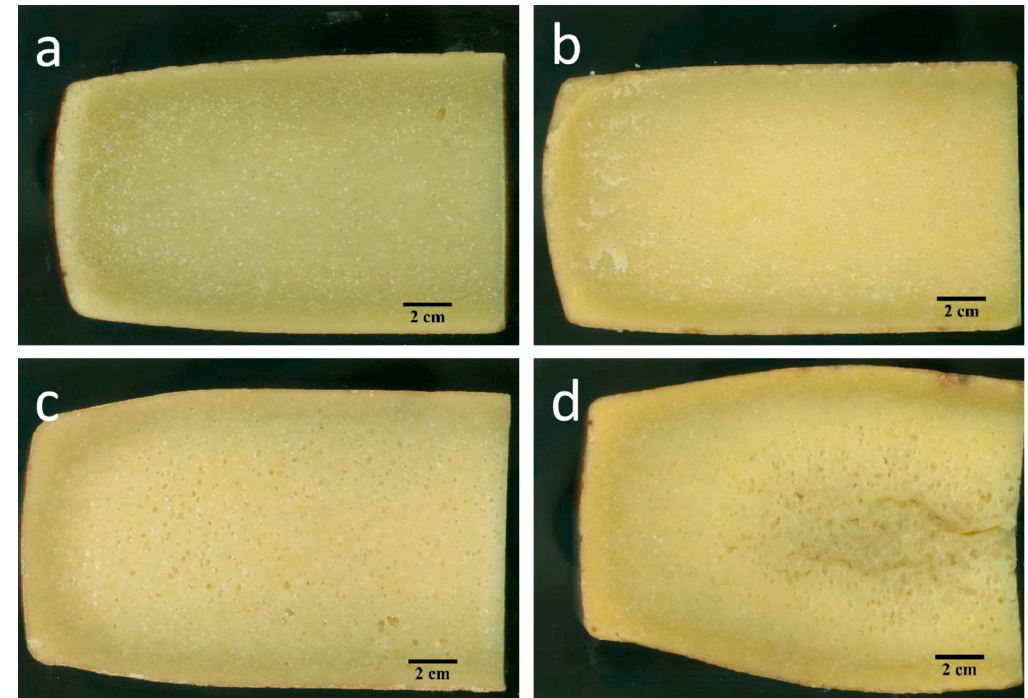
Figure 6. Images of Nostrano Valtrompia cheeses ripened for 12 and 16 months in temperature conditioned warehouse (TCW) and traditional non conditioned warehouse (TNCW). ( a ) TCW at 12 months of ripening; ( b ) TCW at 16 months of ripening; ( c ) TNCW at 12 months of ripening; ( d ) TNCW at 16 months of ripening.